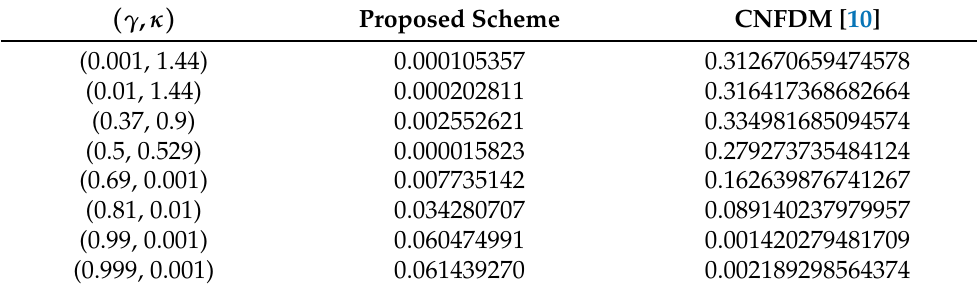
Table 2. Absolute error profile for Example 1 when τ = 1